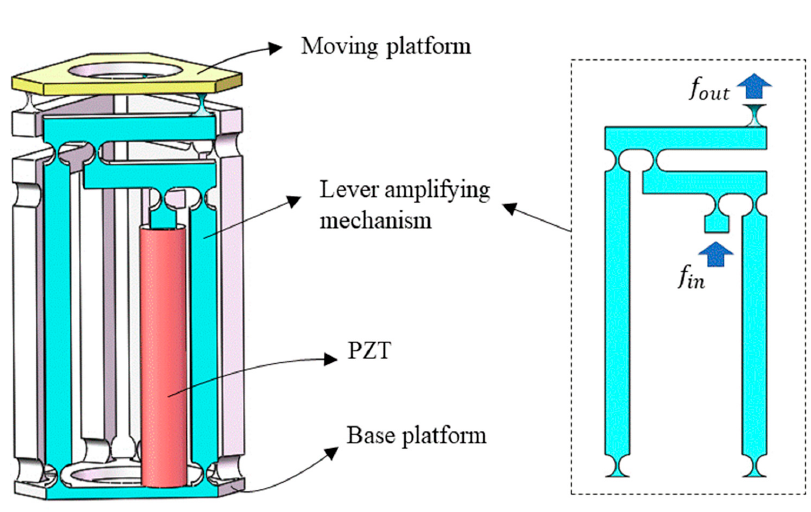
Figure 3. Model of a 3-DOF flexible micro-motion platform.